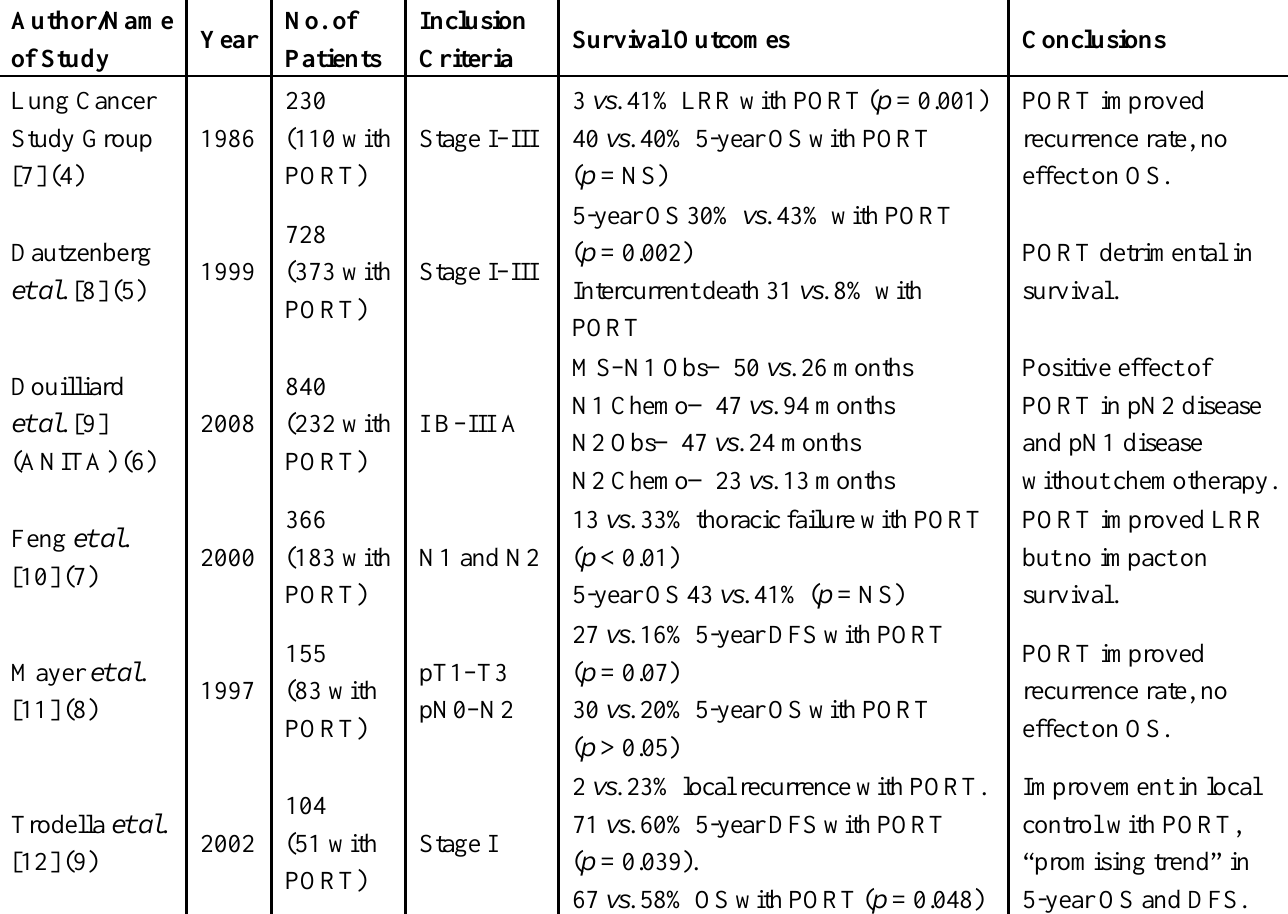
Table 1. Selected clinical trials evaluating postoperative radiation therapy in the setting of non-small cell lung